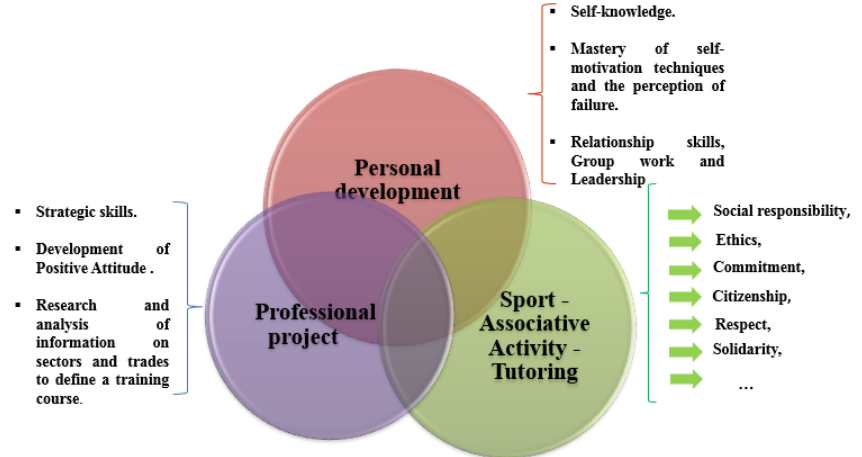
Fig. 8. Soft skills module